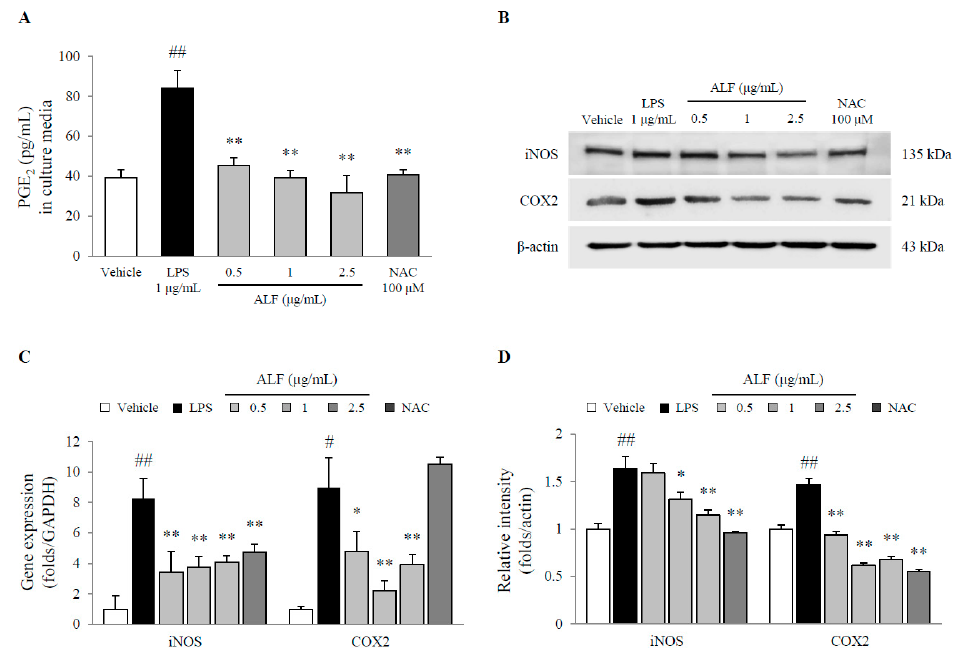
Figure 3. Prostaglandin E 2 (PGE 2 ) production and inducible nitric oxide synthase (iNOS) and cyclooxygenase-2 (COX-2) expression in BV2 cells. Cell supernatant PGE 2 levels ( A ), protein expression of iNOS and COX-2 ( B ), and gene expression of iNOS and COX-2 relative to that of GAPDH ( C ) were determined using ELISA ( n = 6), Western blot ( n = 3), or real-time PCR ( n = 3) methods. Semiquantification of protein expression was performed with normalization to β -actin ( D ). The data are expressed as the mean ± SD. # p < 0.05 and ## p < 0.01 compared with the vehicle-treated cells; * p < 0.05 and ** p < 0.01 compared with the LPS-treated BV2